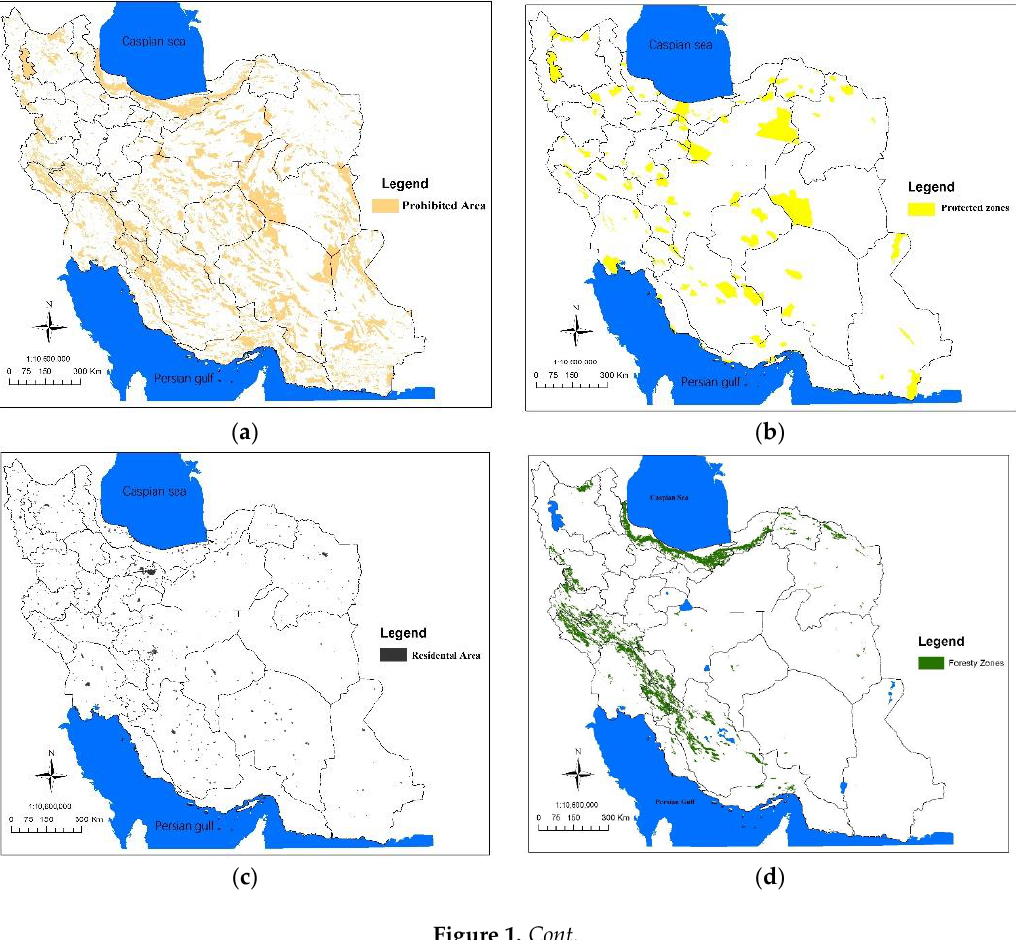
Figure 1. Cont. Figure 1.